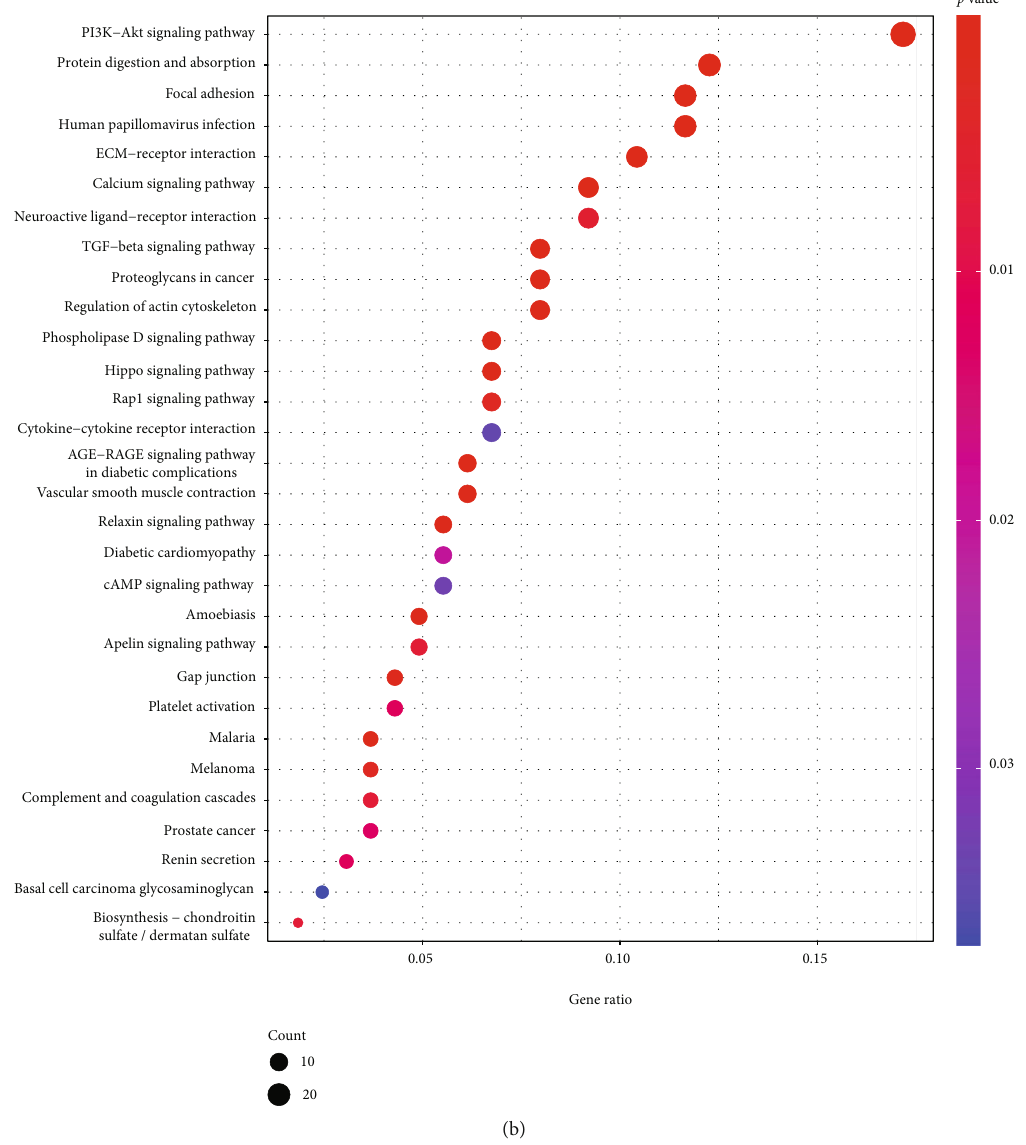
Figure 3: (a) Gene Ontology enrichment analysis. (b) The top 30 enriched KEGG